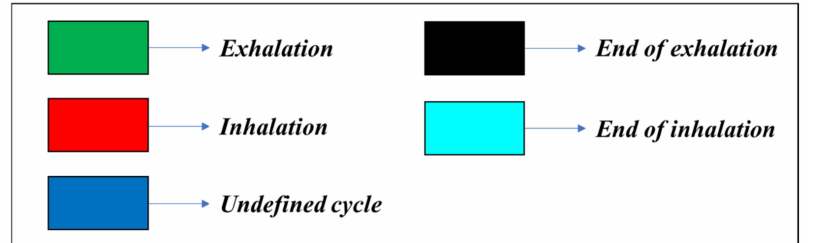
Figure 5. The legend of signal